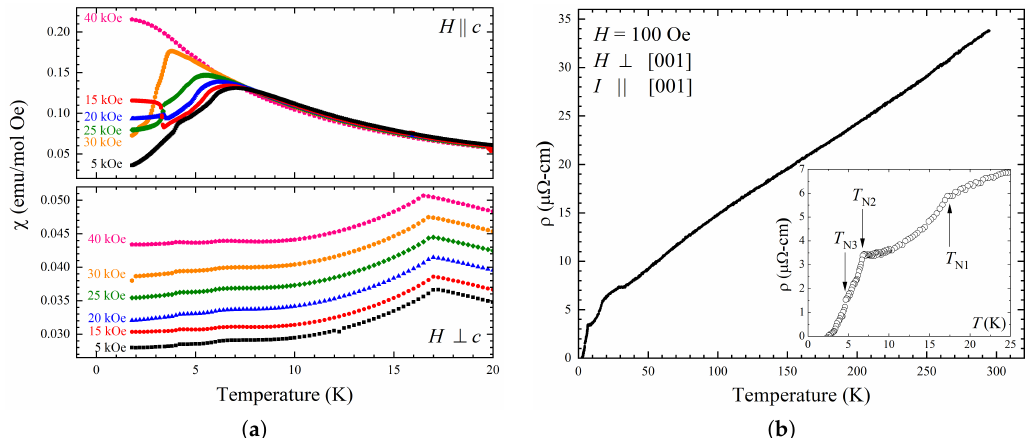
Figure 4. ( a ) Temperature dependent magnetic susceptibility measurements for NdB 4 in magnetic fields between 5 and 40 kOe for H (cid:107) c (top left) and H ⊥ c (bottom left). For H ⊥ c each curve is offset by 0.003 emu/mol Oe. ( b ) Temperature dependent resistivity measurements for a single crystal of NB 4 with H ⊥ c in a magnetic field of 100 Oe. Inset: low temperature ρ ( T ) for NdB 4